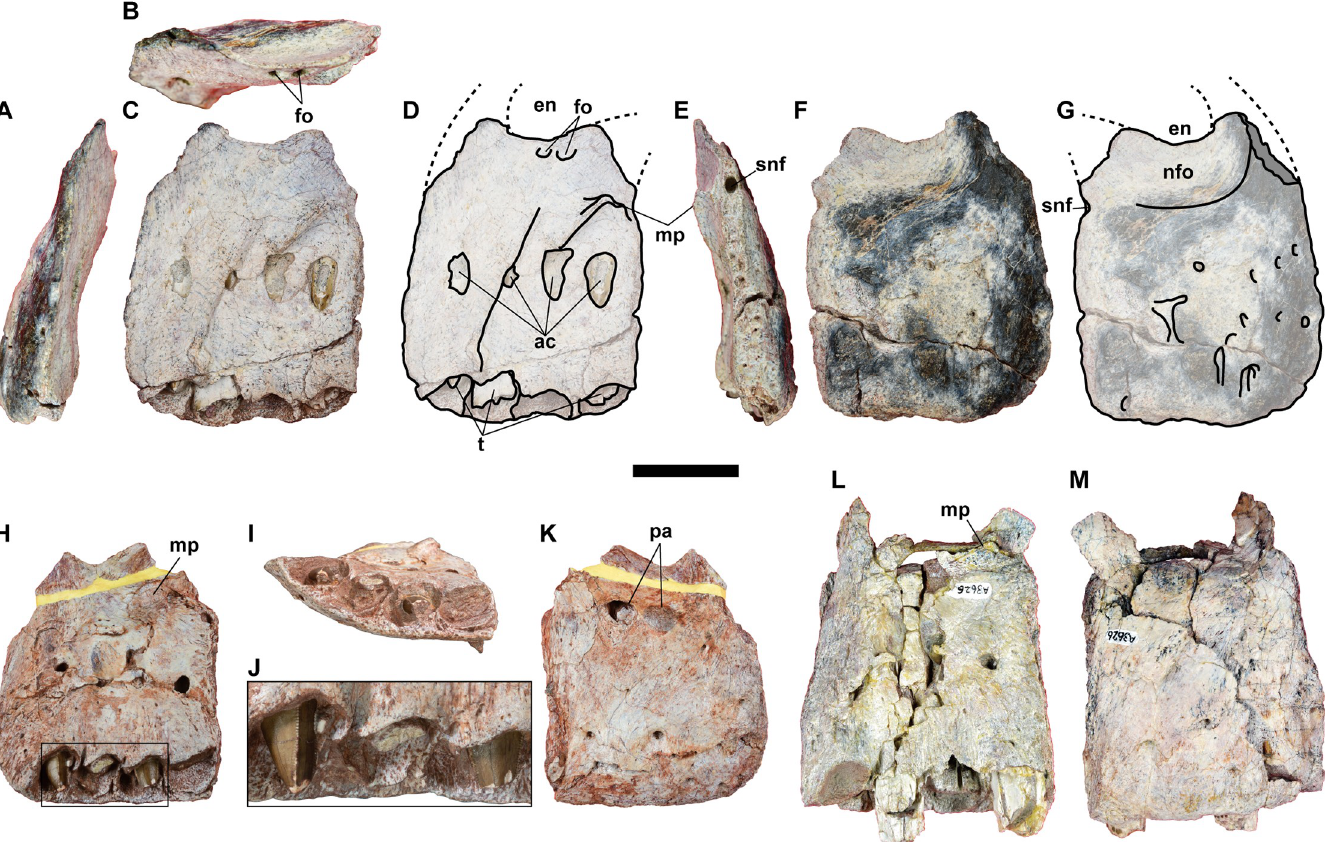
Fig 3. Right premaxillae, NRRU-F01020003 (A–G), F01020002 (H–K) and F01020001 (L, M) in anterior (A), dorsal (B), medial (C, D, H, L), posterior (E), lateral (F, G, K, M) and alveolar (I) views. The rectangle in H indicates the area magnified in J to show premaxillary teeth. Abbreviations: ac, alveolar channel; en, external naris; fo, foramen; mp, maxillary process; nfo, nasal fossa; pa, possible pathology; snf, subnarial fossa; t, tooth. Scale bar equals 50